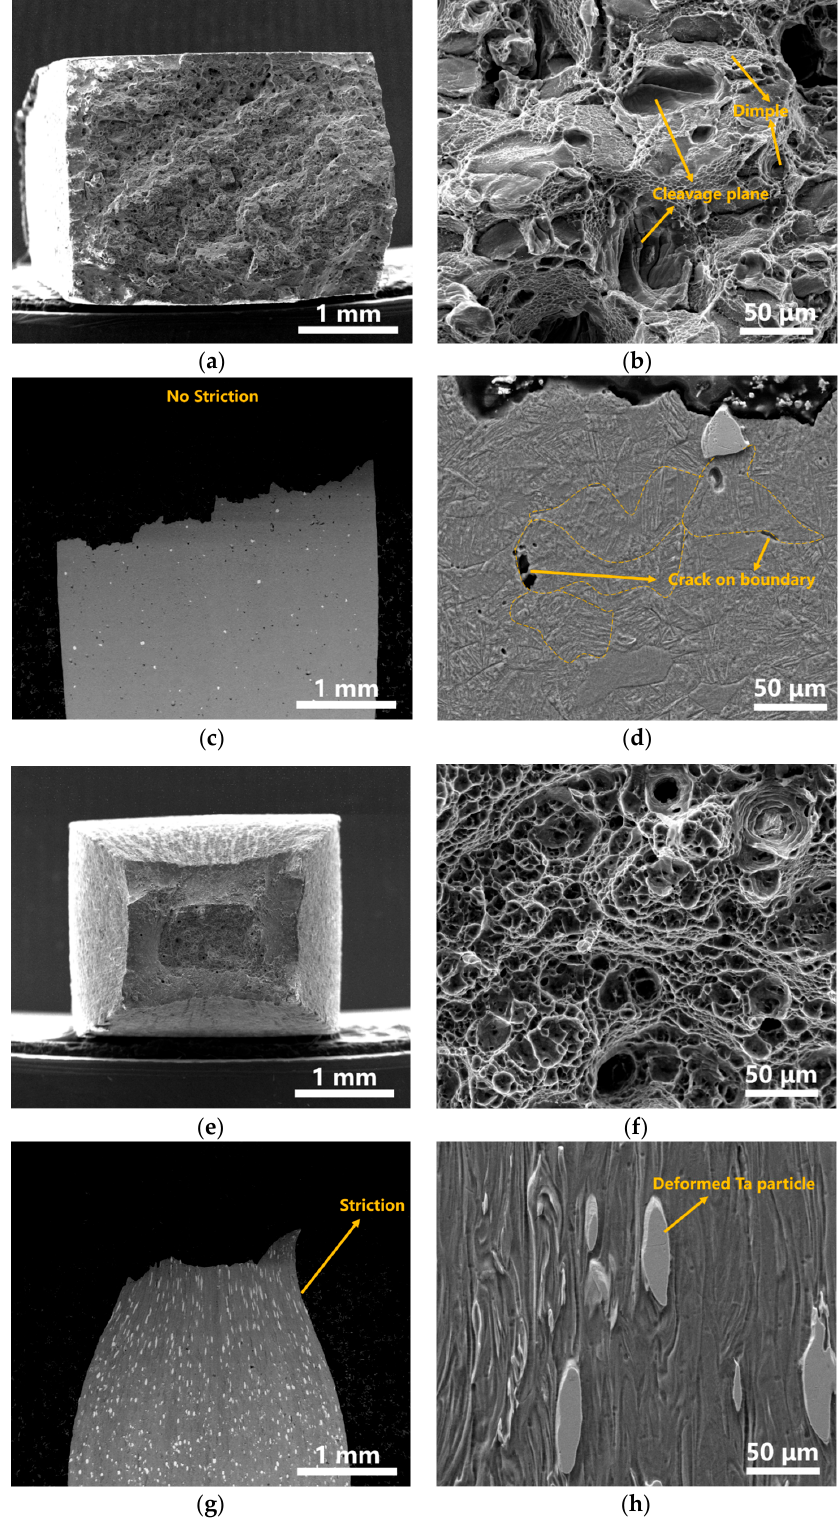
Figure 14. Morphology of fracture in LPBF Ti ‐ Ta samples: ( a , b ) are cross ‐ sectional fracture images of sample S2 with different magnification; ( c , d ) are longitudinal cross ‐ sectional fracture images of sample S2; ( e , f ) are cross ‐ sectional fracture image of sample S3 with different magnification. ( g , h ) of sample S2; ( e , f ) are cross-sectional fracture image of sample S3 with different magnification. longitudinal cross ‐ sectional fracture image of sample S3. ( g , h ) longitudinal cross-sectional fracture image of sample